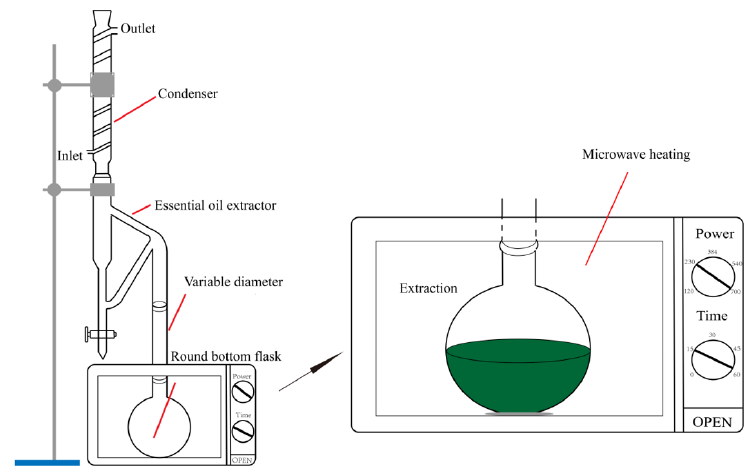
Figure 1. Structure of microwave heating device.